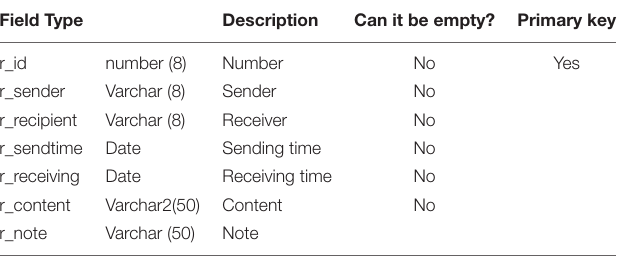
TABLE 4 | Message record